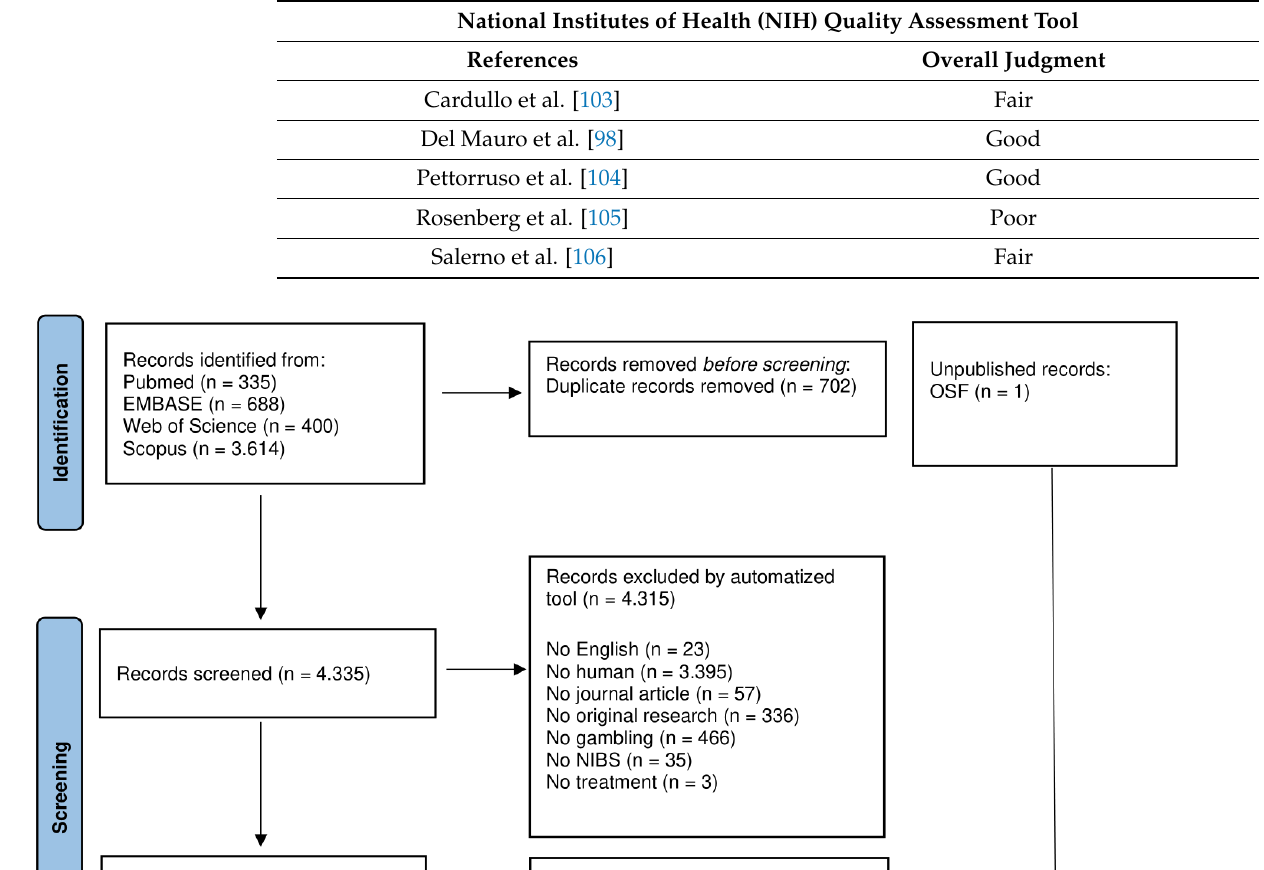
Table 2. Risk of bias assessment related to the papers evaluated through the NIH tool.